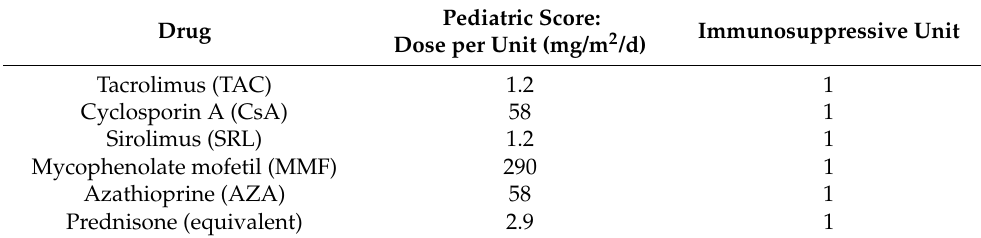
Table 1. Modified Vasudev immunosuppressive score [16]. Pediatric Score: Drug Dose per Unit (mg/m 2